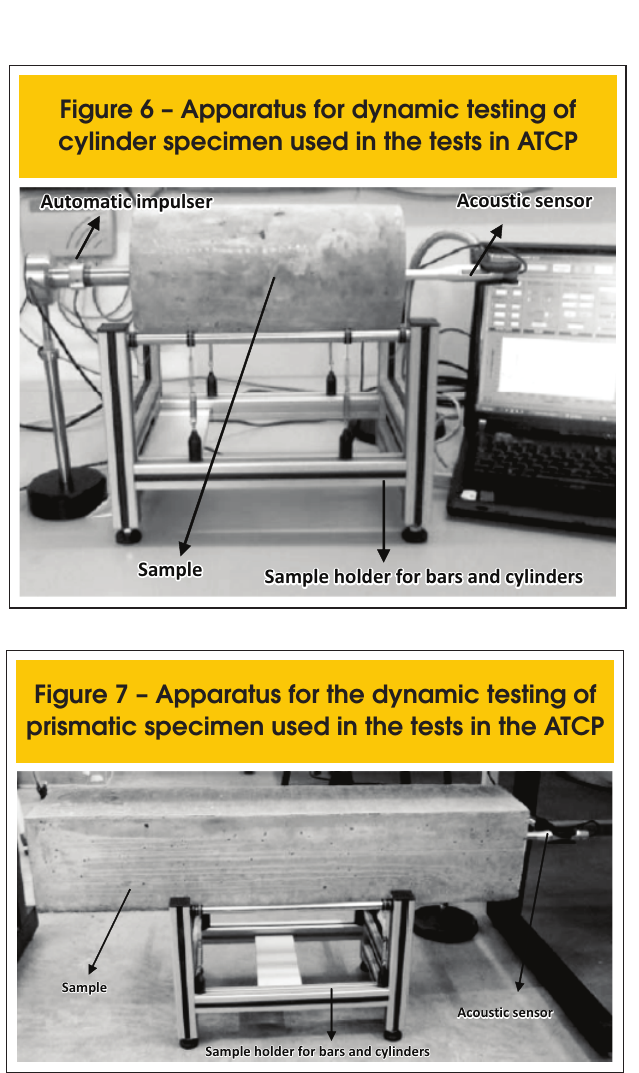
Figure 9 – Arrangement of dynamic testing for prismatic specimen used in the